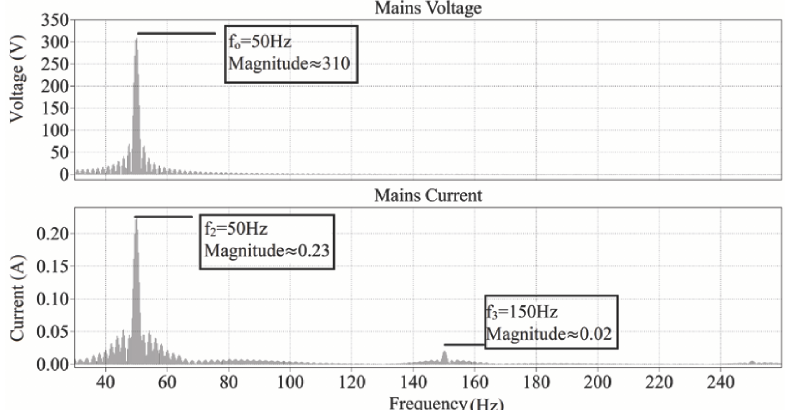
Figure 7. Steady state frequency domain simulation of the converter depicting the input voltage V ac and current i ac showing the low frequency components.